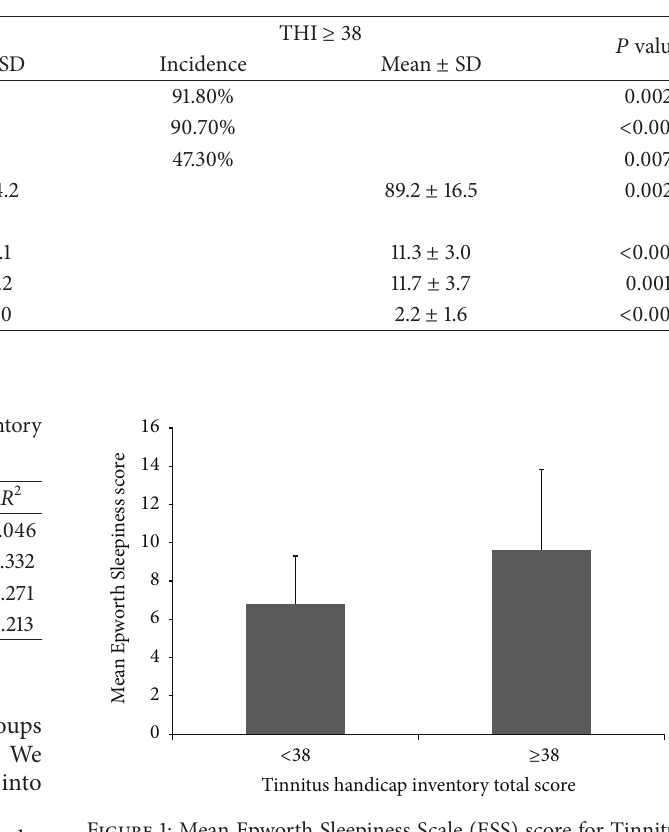
percentage of bilateral tinnitus (100% versus 80%, 𝑃 = 0.025 ), lower left ear word discrimination score (89.8 versus 93.8, 𝑃 = 0.049 ), and higher THS hearing score (13.1 versus 11.4, 𝑃 = 0.028